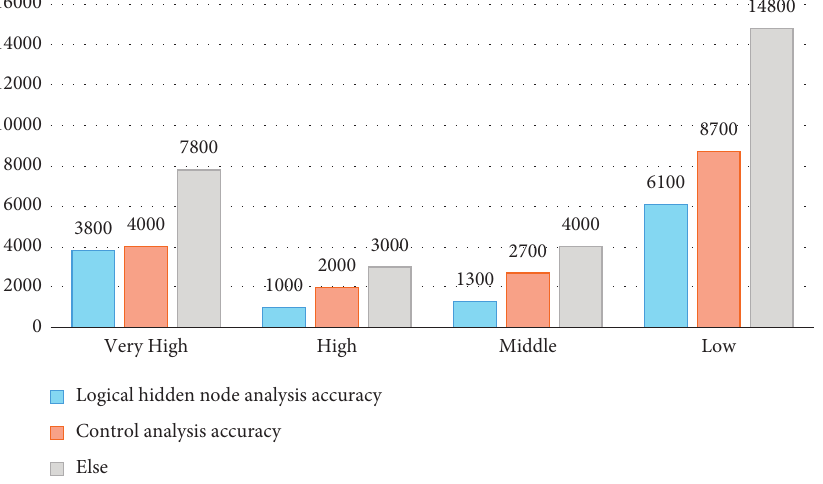
Figure 4: Comparative analysis of the accuracy of logical hidden node analysis.